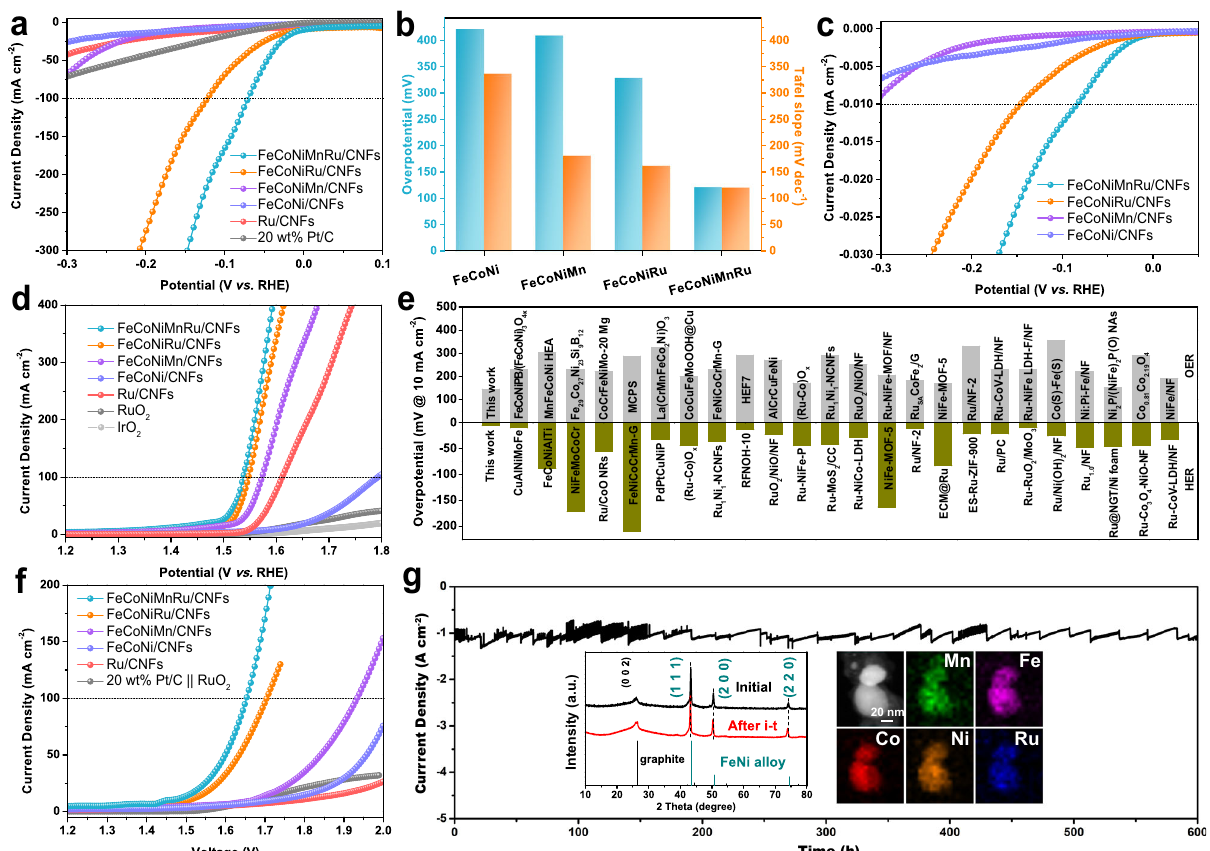
Fig. 4 Electrochemical performance of HEA electrocatalysts. a HER polarization curves, b the corresponding histogram for overpotentials at 100 mA cm – 2 and Tafel slopes obtained for Ru/CNFs, FeCoNi/CNFs, FeCoNiMn/CNFs, FeCoNiRu/CNFs, FeCoNiMnRu/CNFs, and Pt/C in 1.0 M KOH electrolyte. c ECSA-normalized HER polarization curves of the as-prepared electrocatalysts. d OER polarization curves for the as-prepared electrocatalysts, commercial RuO 2 and IrO 2 in 1.0 M KOH electrolyte. e Comparison of HER and OER overpotentials at 10 mA cm – 2 in 1.0 M KOH for different catalysts. Those recently reported literatures for HER and OER electrocatalysts were shown in Supplementary Tables 6 and 7. f Polarization curves for full water splitting by the as- prepared electrocatalysts in a two-electrode con fi guration at a scan rate of 2 mV s – 1 . g Long-term stability measurement of the FeCoNiMnRu/CNFs electrode at − 1.16 V vs. RHE in 1 M KOH electrolyte for 600 h. The insets in ( g ) are the XRD patterns (left) and STEM-EDS mapping images (right) of FeCoNiMnRu/CNFs after the long-term stability